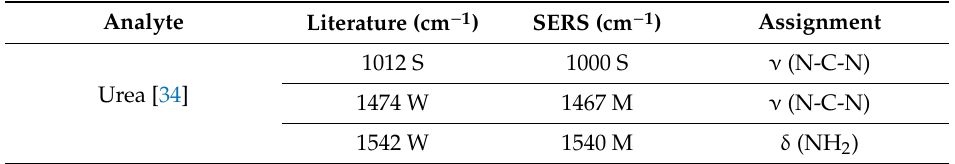
Figure 13. ( a ) SERS spectra of Rhodamine B, urea, potassium nitrate and water sample obtained with our microfluidic chip in combination with maskless ion etched SERS substrates, ( b ) the baseline corrected SERS spectra of Rhodamine B, urea and potassium nitrate by subtracting water as reference. Each spectrum is obtained over 10 measurements. Table 2. Main SERS bands of urea, potassium nitrate and Rhodamine B and their relative intensities and assignments ( ν : stretching, δ : deformation; S: strong, M: medium, W: weak).